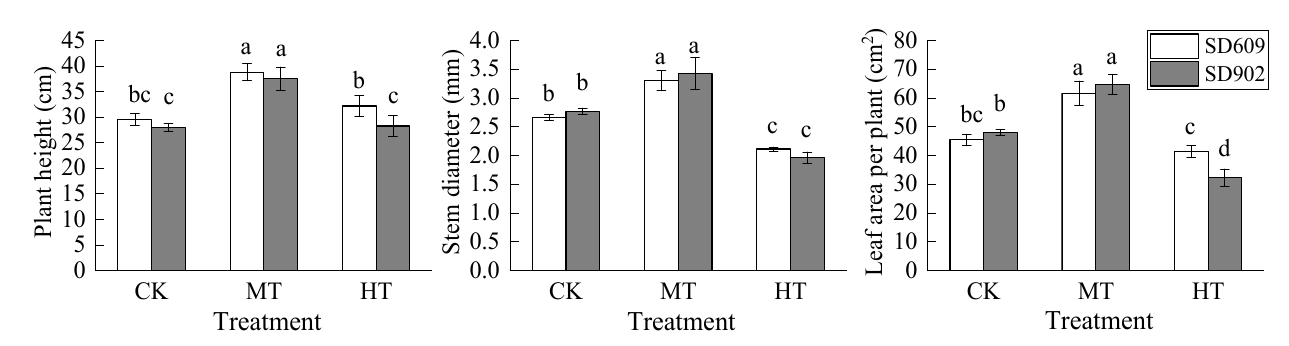
Figure 4. Effects of different root zone temperatures on plant height, stem diameter, and leaf area of SD609 and SD902. CK: 24 ◦ C, MT: 30 ◦ C, HT: 36 ◦ C (root zone temperature). Notations above bars of a, b, c, d indicate homogeneous groups ( α = 0.05). Table 2. Effects of different root zone temperatures on the leaf microstructure of SD609 and SD902. Cultivar